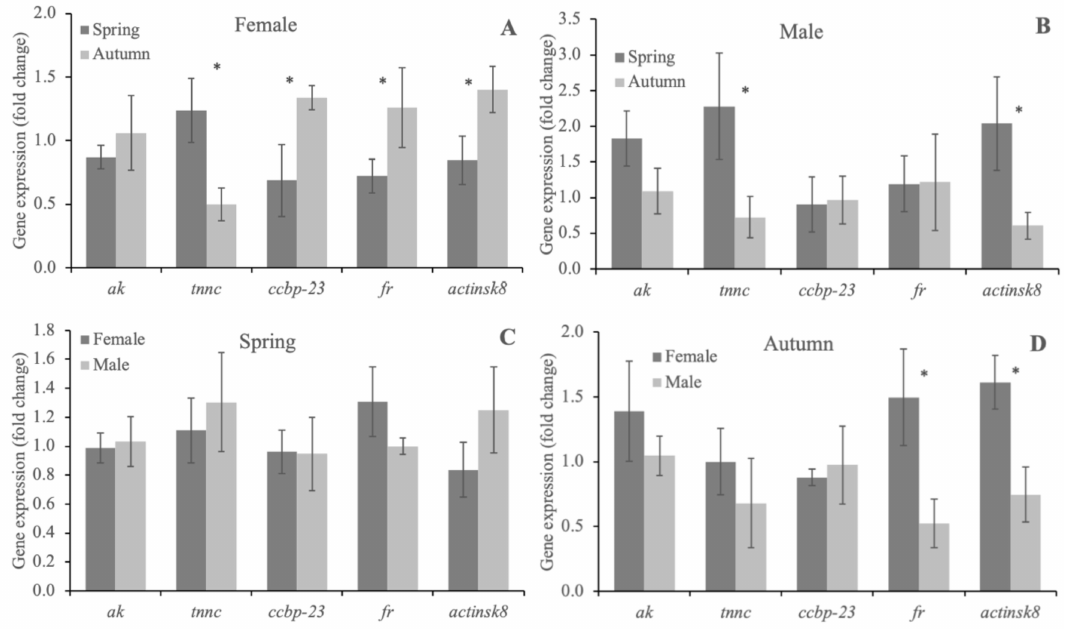
Figure 4. Expression (mean + SD) of ak , tnnc , ccbp-23 , fr , actinsk8 in the muscle tissue of F. limosus males and females in spring and summer. Abbreviations: A —gene expression in female samples in spring and autumn, B —gene expression in male samples in spring and autumn, C —gene expression in female vs. male samples in spring, D —gene expression in female vs. male samples in autumn, * p ≤